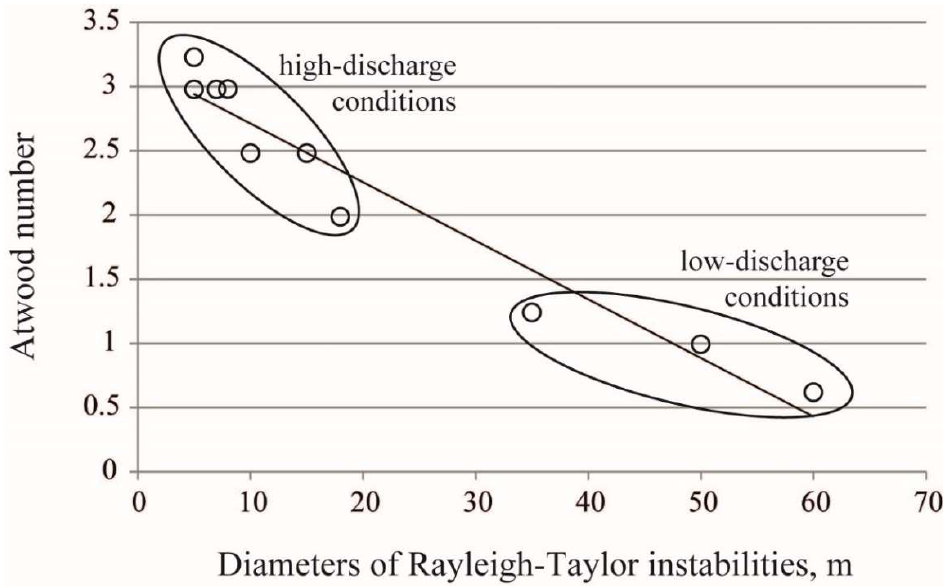
Figure 12. Dependence of diameters of Rayleigh–Taylor instabilities on the Atwood number. The black line represents linear regression.